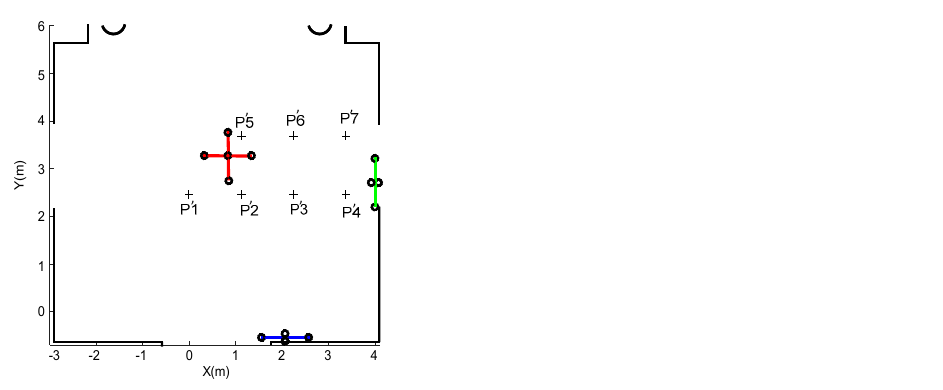
Figure 7. Workspace configuration and grid of positions considered to evaluate the positioning performance. ULPS-1 is plotted in red, ULPS-2 in blue, and ULPS-3 in green.